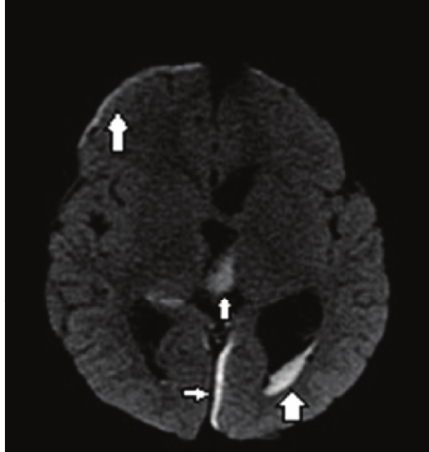
Figure 5: Brain MRI on day 5 for meningitis evaluation. Axial diffusion weighted MR image of the brain shows restricted diffusion over the right frontal lobe and left medial occipital lobe and in the ventricles suggesting subdural empyemas and intraventricular abscesses